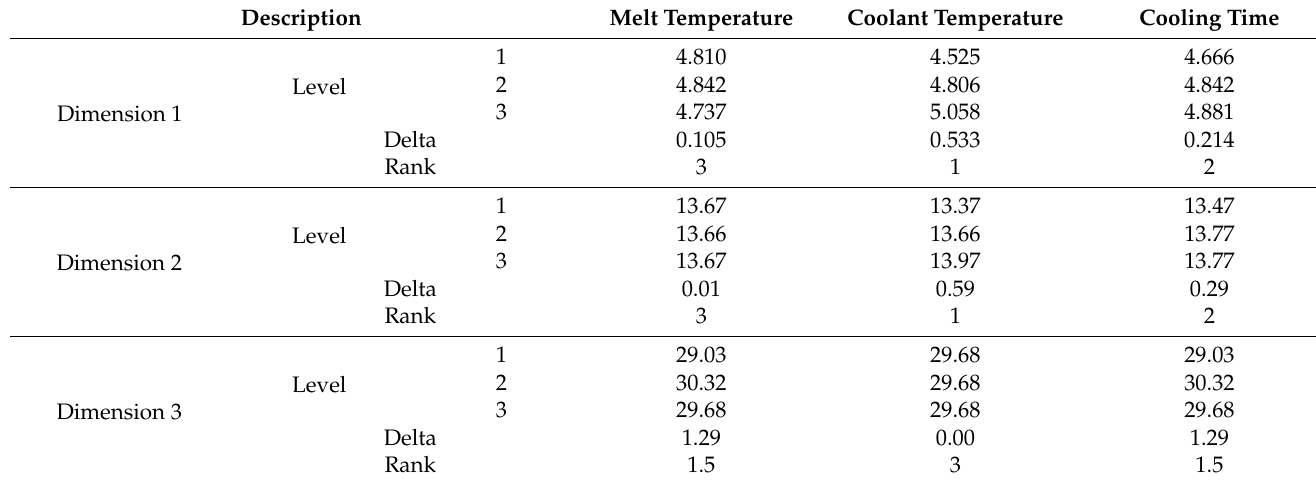
Table 20. Average of S/N ratio for each level of factors in open